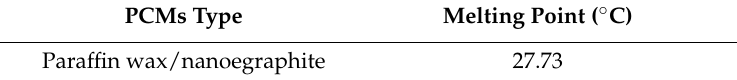
Table 2. Organic nanoparticle properties [49] .